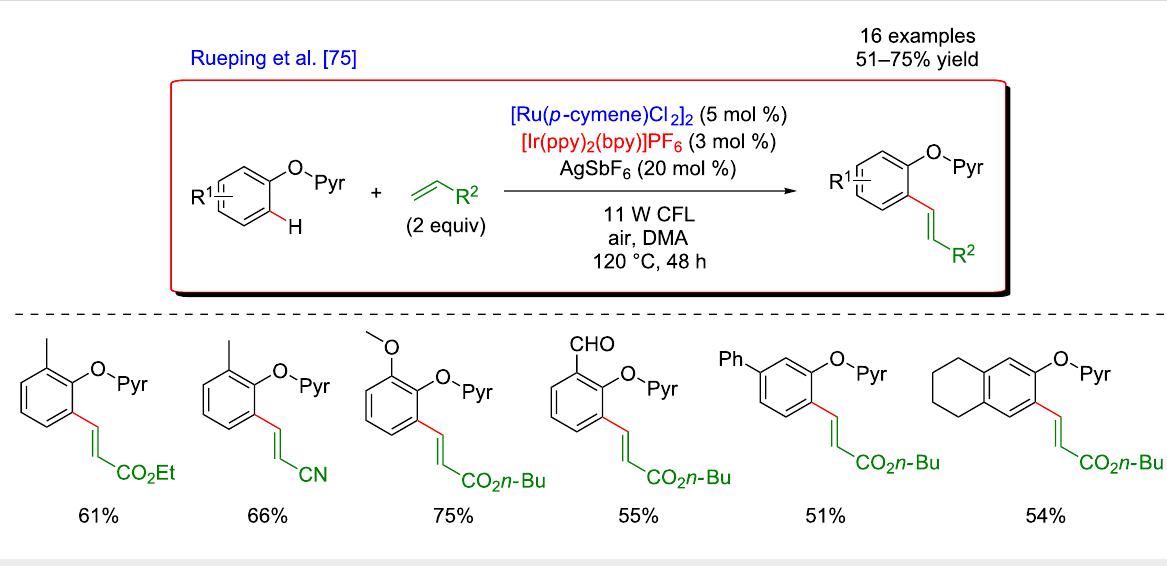
Figure 9: Oxidative Heck reaction on phenols via the dual catalysis.